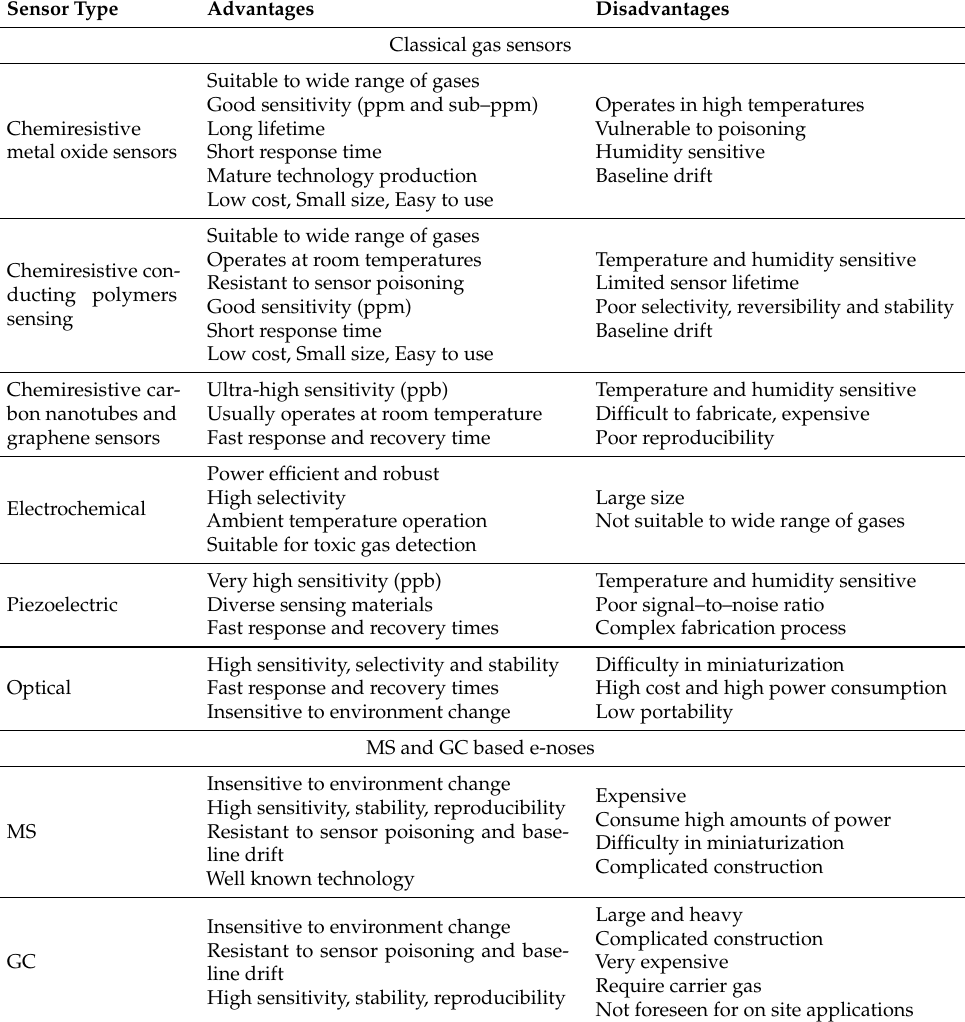
Table 5. Advantages and disadvantages of different sensor types used in e-noses based on